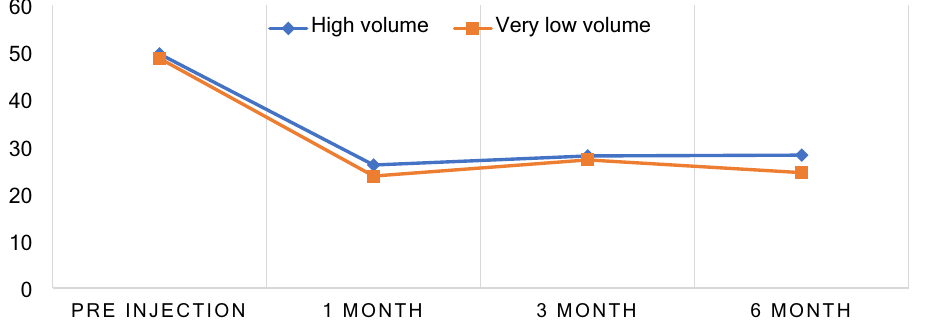
Figure 5. Mean DASH score by the progression time to treatment with SCI.